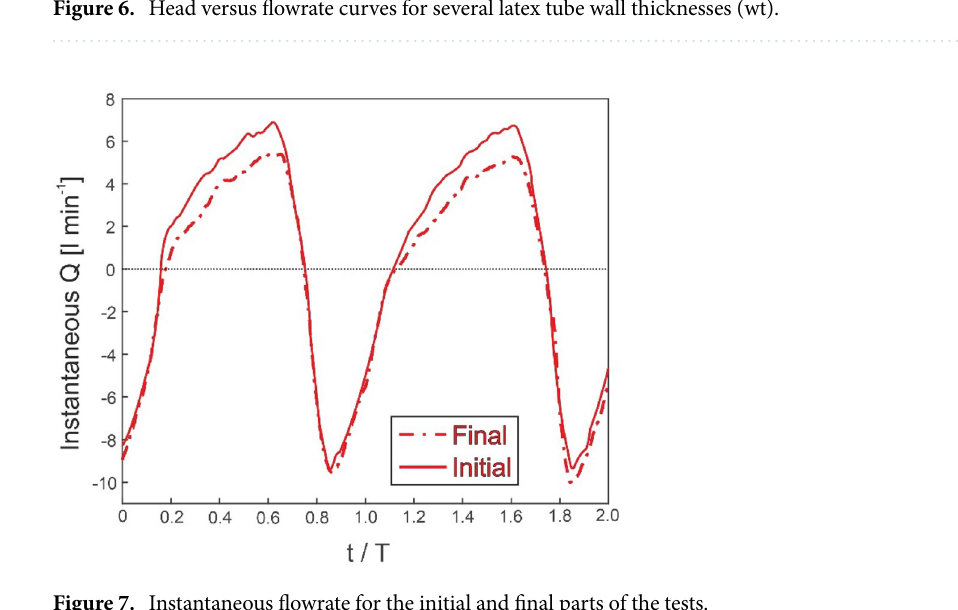
Figure 7. Instantaneous flowrate for the initial and final parts of the